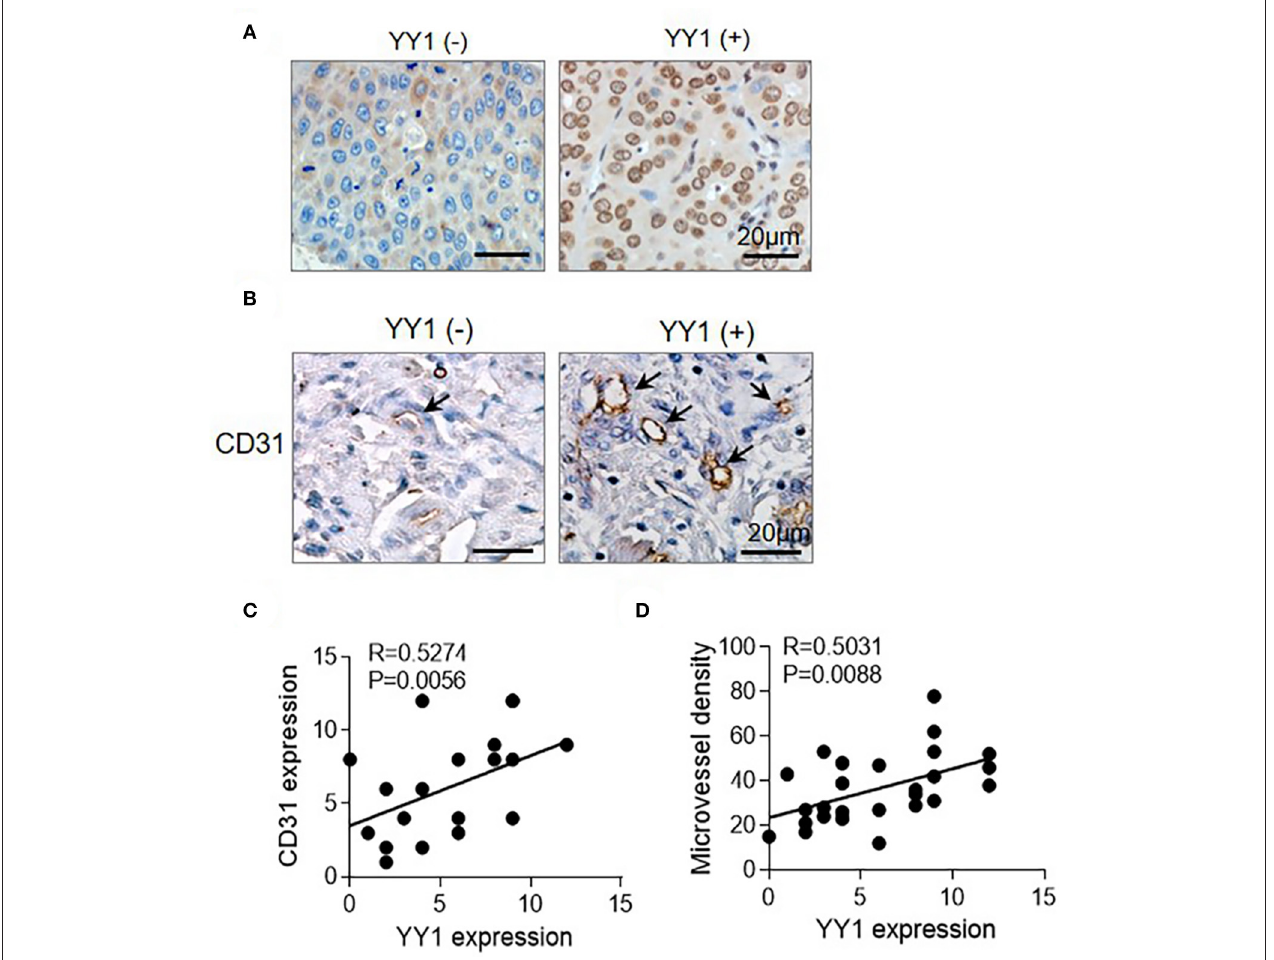
FIGURE 1 | YY1 was associated with HCC angiogenesis. (A) Representative images of IHC staining for YY1 of human HCC tissues at different stages (left, stage I; right, stage IV). Scale bar = 20 µ m. (B) MVD measured by immunostaining for CD31 in YY1-negative and positive HCC tissues. Black arrows indicate microvessels. Scale bar = 20 µ m. (C) CD31 and YY1 stains were quantified and the correlation was analyzed (correlation coefficient: R = 0.5274, P = 0.0056). (D) MVD and YY1 stains were quantified and the correlation was analyzed (correlation coefficient: R = 0.5031, P = 0.0088).